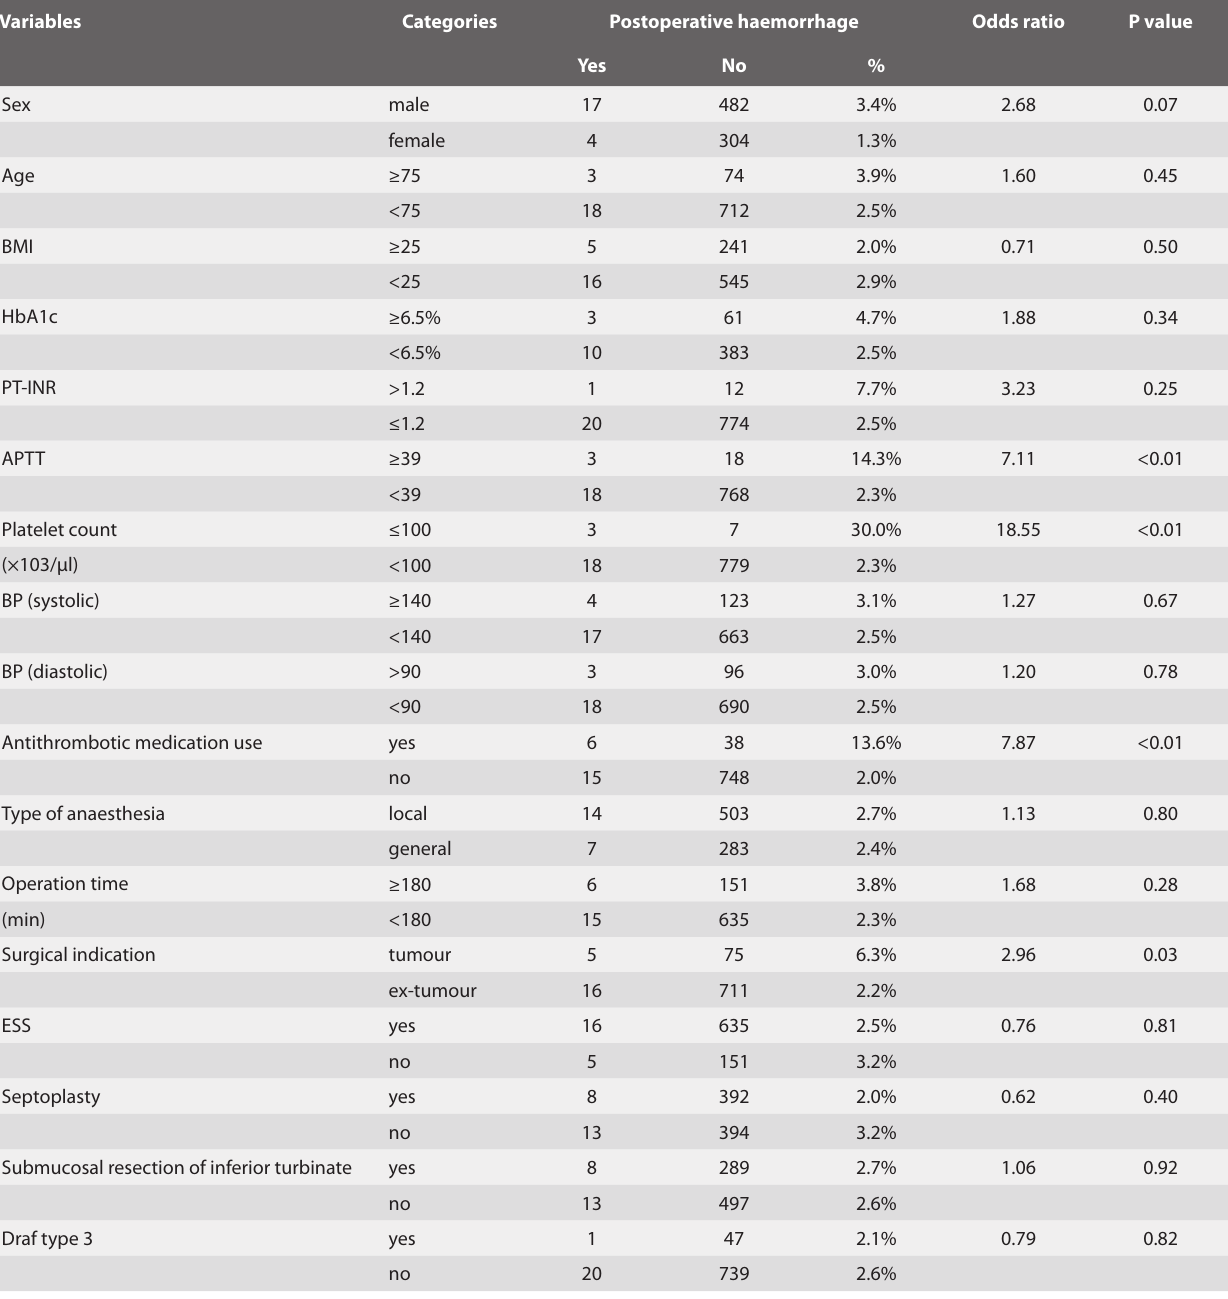
Table 2. Univariate analysis of association between factors enrolled and postoperative